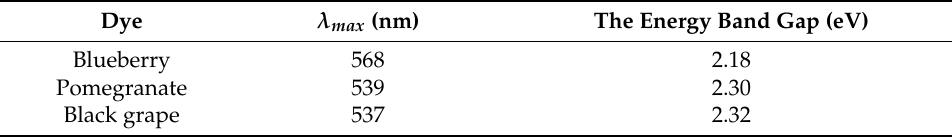
Table 3. Energy bandgap values of blueberry, pomegranate, and black grape dye. Dye λ max (nm) The Energy Band Gap (eV) Blueberry 568 2.18 Pomegranate 539 2.30 Black grape 537